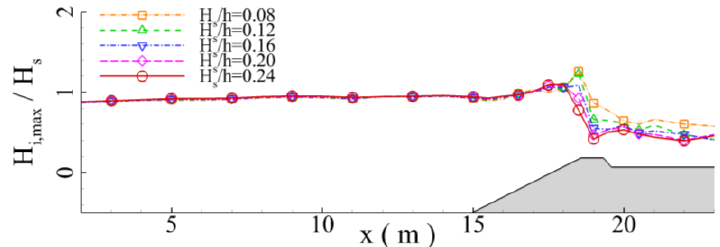
Figure 18. Maximum water surface elevation at the reef crest versus the relative significant wave height.